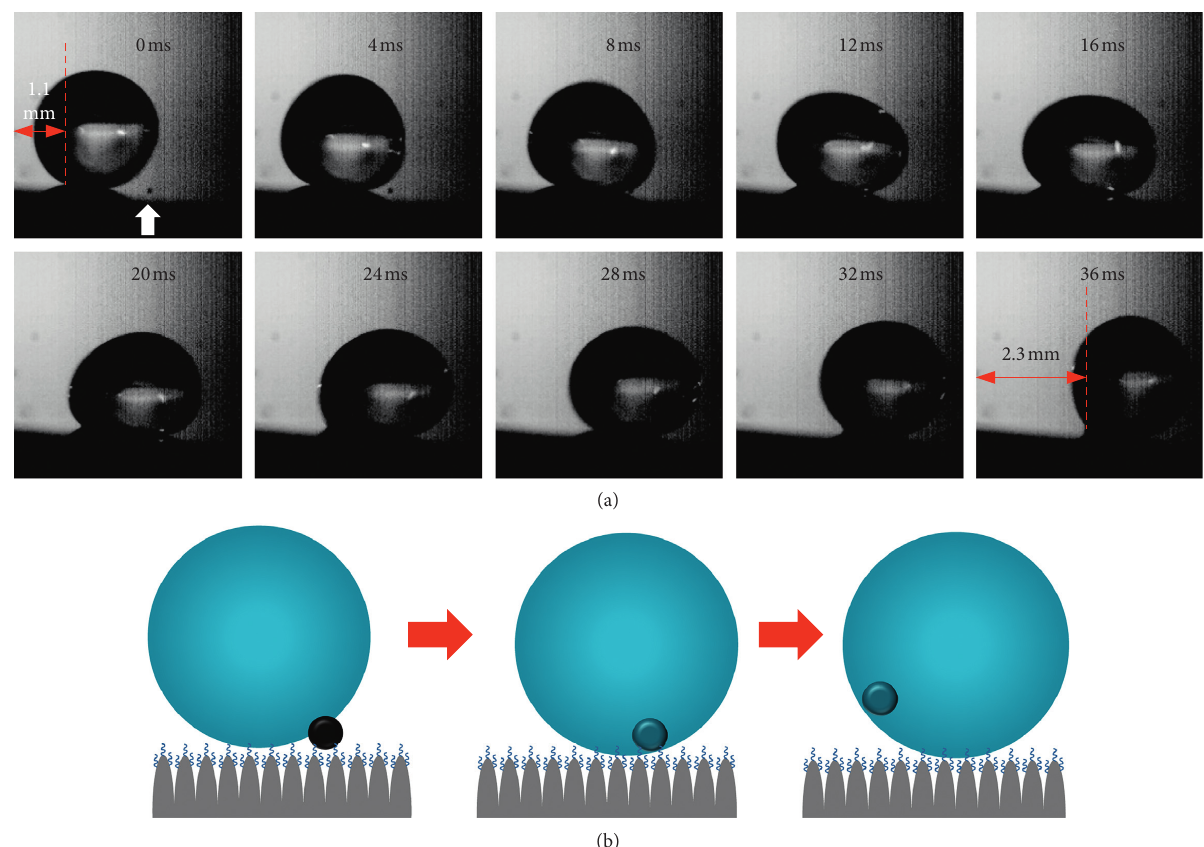
Figure 9: “Rolling” cleaning mode: (a) photos recorded by using a high speed camera and (b) schematic of antifouling